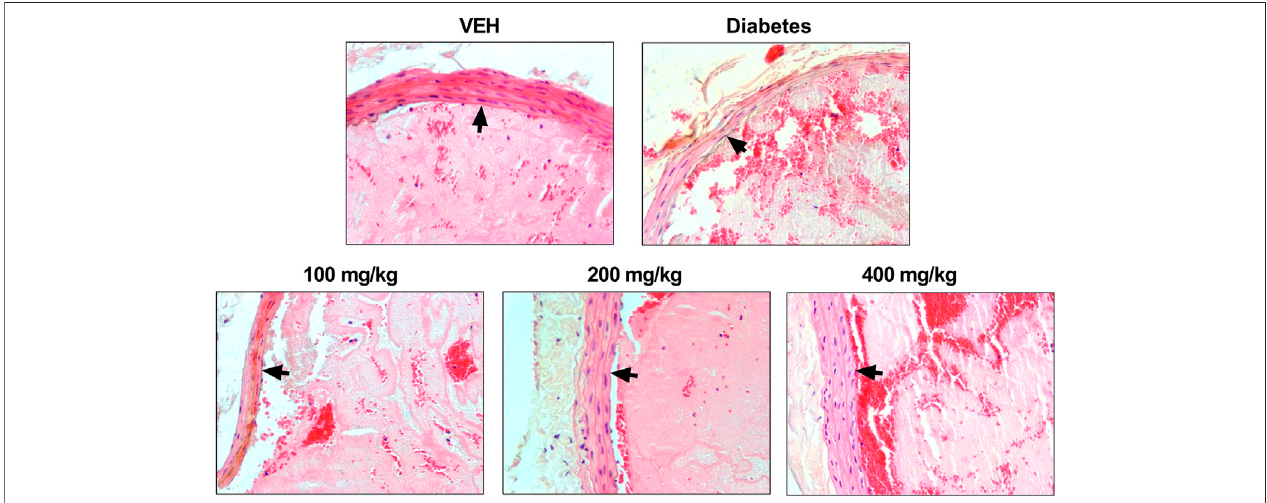
FIGURE 3 | Representative photomicrographs of the thrombi and rat carotid artery wall. Fibrin and platelet aggregates are stained pink, erythrocytes are stained red, leukocytes are stained blue, and black arrows indicate the arterial wall. Routine H and E staining, × 200 magni fi